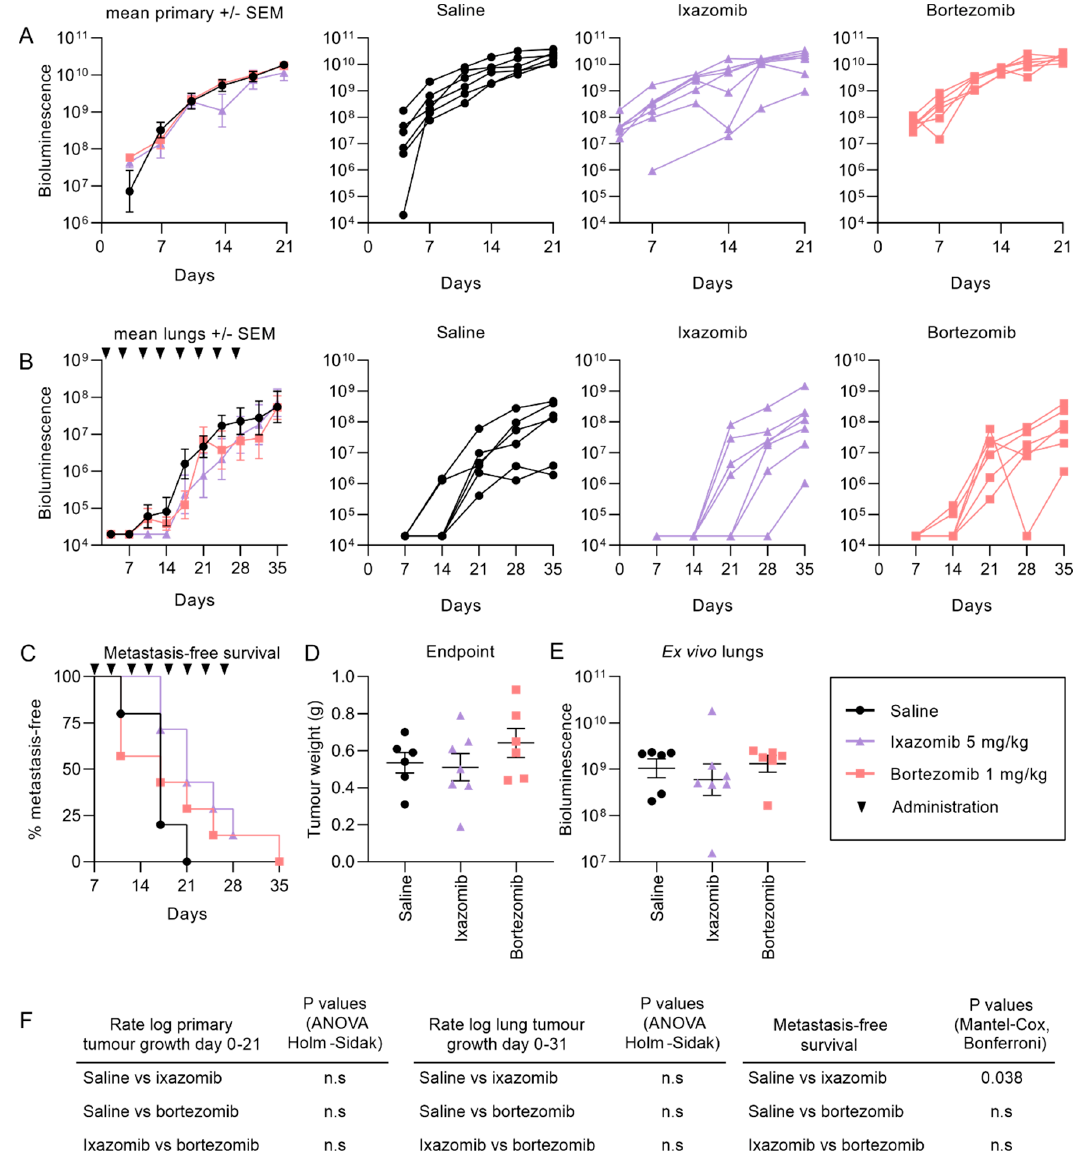
Figure 2 . Ixazomib delays the formation of pulmonary metastases in mice bearing intramuscular KRIB osteosarcoma tumors. KRIB-luc cells were implanted into the tibialis anterior muscle of nude mice and one week later commenced treatment with saline, ixazomib or bortezomib, twice weekly for 4 weeks ( A ). Primary tumors were shielded from the camera and mice were imaged facing up twice a week to monitor the growth of lung metastases ( B ). A Kaplan Meier curve was used to compare the rate of formation of detectable metastases in mice between the three treatment groups ( C ). Tumors were removed from mice at the end of the experiment and weighed ( D ). Lungs were removed from the mouse at the end of the experiment and lung tumors imaged by bioluminescence ex vivo ( E ). Rate of growth of tumors between treatment groups and the duration of metastasis-free survival were compared ( F ). (n = 6 for bortezomib and saline and 7 for ixazomib, +/ − SEM).